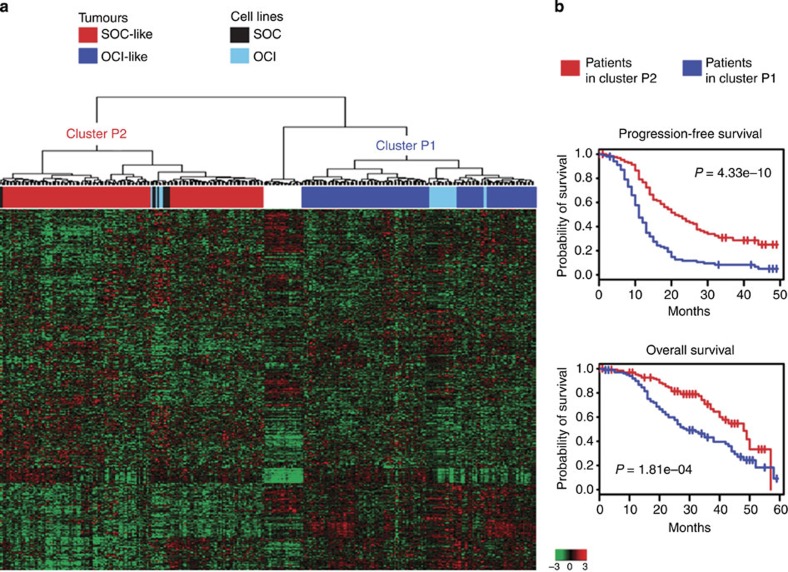
The OCI lines identify two major outcome groups.(a) Unsupervised hierarchical clustering of gene expression data of 37 cell lines and 285 human tissues reveal three clusters. Genes with ≥2-fold expression differences relative to the median value across cell lines and tissues in at least four samples were selected for hierarchical clustering analysis (3,831 gene features). Rows represent individual genes and columns represent each cell line or tissue. The red and green colour in cells reflect relative high and low expression levels, respectively, as indicated in the scale bar (log2-transformed scale). Red and blue bars above the heatmap indicate human tumour samples; light-blue bars indicate OCI lines; and black bars indicate SOC lines. While SOC cell lines (black bars) are exclusively group within patient cluster P2 (red bar), the OCI cells (light-blue bars) predominantly group within patient cluster P1 (blue bar). A small subset of tumour samples form a third cluster that does not include any cell lines (white); this group was excluded from outcome analysis. The complete mRNA expression data set is available at Gene Expression Omnibus, GEO accession number GSE40788 and GSE9899. (b) The progression-free and overall survival analysis data of patients with the ovarian tumours in patient cluster 1 and 2 in a. The patients with tumours that have a gene expression profile to OCI lines (blue bar, cluster 1 in a) have worse outcomes than patients with tumours that have gene expression profiles similar to SOC lines (red bar, cluster 2 in a). The small cluster of tumours that did not include any cell lines (white) was excluded from the outcome analysis.